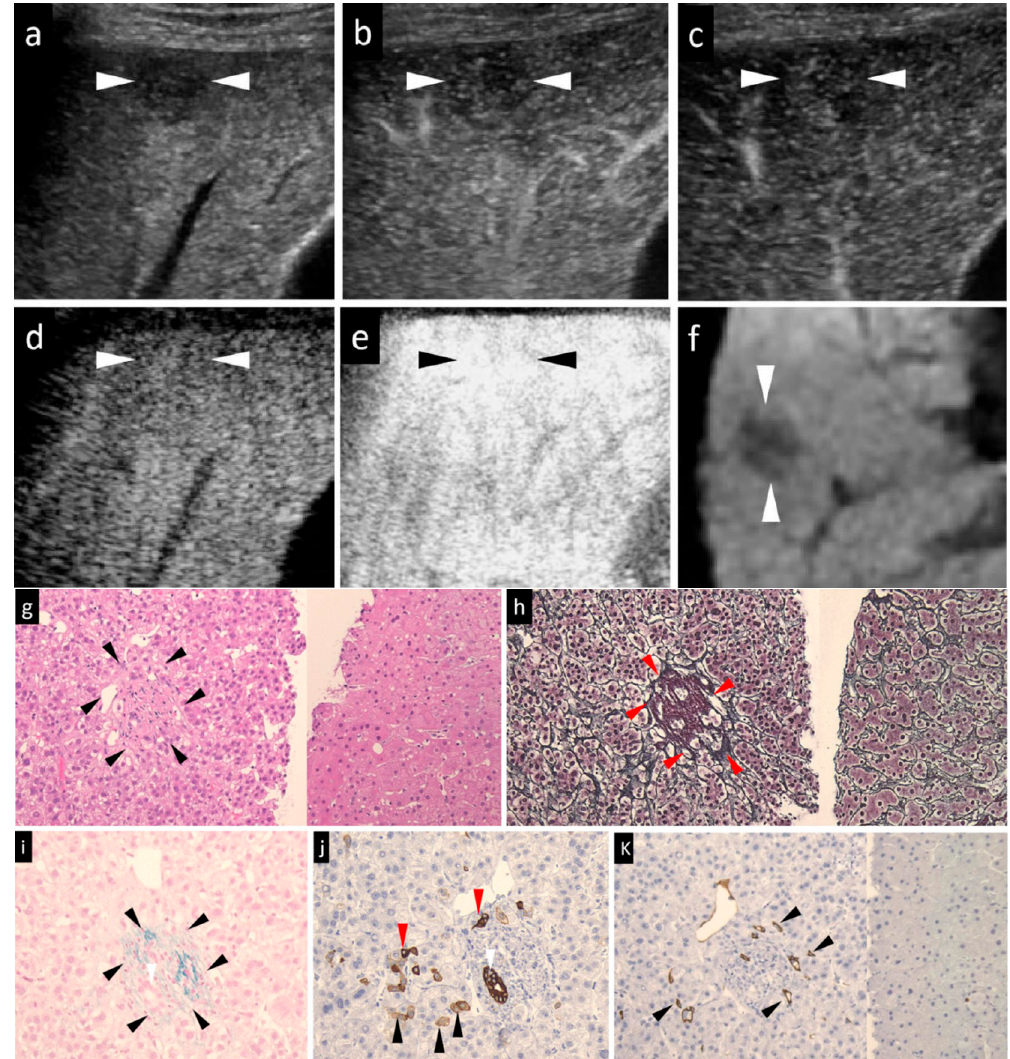
Figure 1. A case of early HCC (maximum diameter, 15 mm) in segment V with the typical imaging patterns and histological staining. The patient was a 65-year-old male. ( a ) Grayscale US showed a slightly hypoechoic lesion in segment V, near the surface of the liver. Neither the halo nor the mosaic sign was positive. ( b , c ) Arterial-phase Sonazoid CEUS image obtained using low-mechanical index (MI) harmonic imaging showed slight transient hypovascularity ( b ) and the lesion was seen as an isovascular lesion in the subsequent portal-phase image ( c ). ( d ) Post-vascular phase CEUS image obtained with low-MI contrast imaging showed an isoechoic tumor. ( e ) After the imaging mode was switched to high-MI contrast imaging, the post-vascular phase showed an isoechoic tumor. ( f ) The lesion was seen as a hypointensity in segment V in the hepatobiliary-phase image of Gadolinium ethoxybenzyl diethylenetriamine pentaacetic acid magnetic resonance imaging (Gd-EOB-DTPA MRI). ( g ) Hematoxylin–eosin (HE) staining. As compared to the non-tumor area (right side), early HCC (left side) showed the cancer area (arrowheads) has a slight cellular atypia, a mild increase in the nuclear-cytoplasmic ratio, and hypercellularity. The trabeculae were arranged clearly. ( h ) Silver staining of the tumor area (left side) and non-tumor area (right side). In early HCC, the reticular fibers were clear and evenly distributed, much resembling the findings in the non-tumor area. Red arrowheads indicated portal tracts. ( i ) Victoria blue staining of the tumor area showed elastic fibers surrounding the portal tract in blue (arrowheads). Positive stromal (portal tract) invasion, namely, cancer cells within the portal tract, were compatible with the diagnosis of early HCC. ( j ) Cytokeratin 7 staining of the tumor area. No ductular reaction could be seen in this figure. The progenitor cells were small cells with dense staining of the cytoplasm (red arrowheads). Black arrowheads indicated intermediate hepatocytes with faint staining of the cytoplasm. The white arrowheads in ( i ) and ( j )